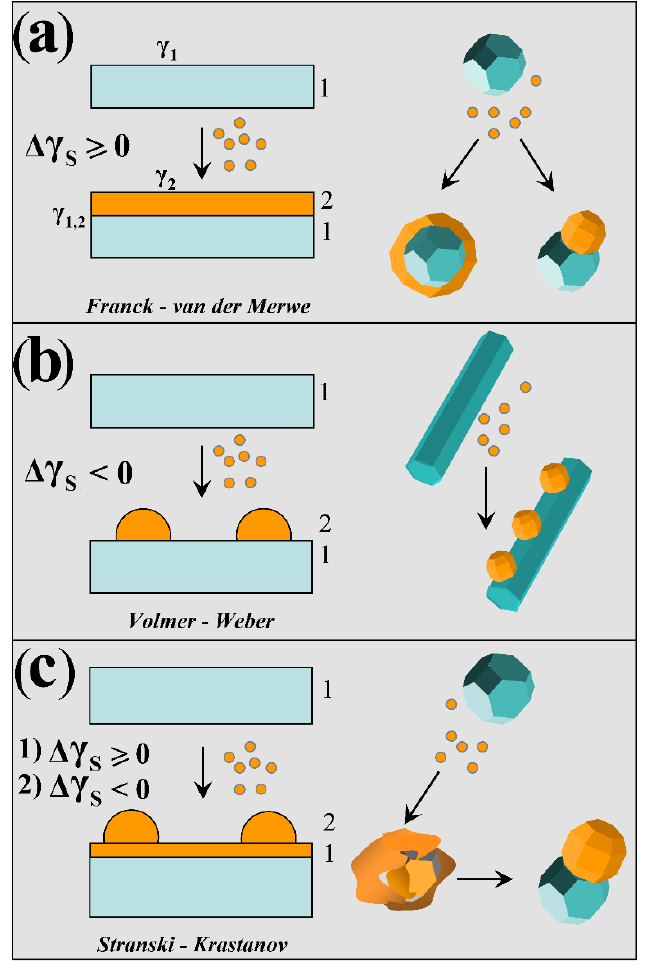
Scheme 1. Sketch of the predictable modes by which a secondary material (labelled as “2”) may develop over a pre-existing (hetero)nanocrystal substrate (seed) made of a different primary mate- (adapted with permission from Ref. [27], Copyright 2008, Wiley-VCH Verlag GmbH & Co.